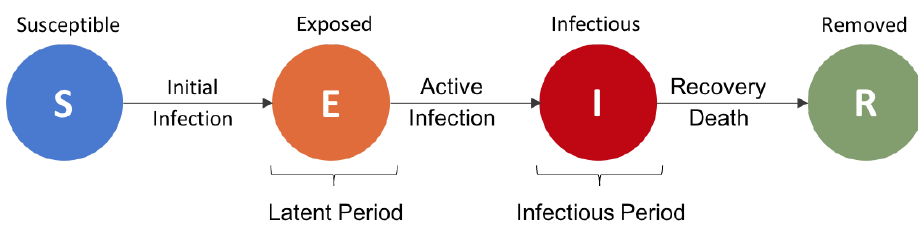
Figure 5. States (compartments) of the basic SEIR model, Susceptible (S), Exposed (E), Infectious (I), and Removed (R), corresponding to the disease development stages over time.